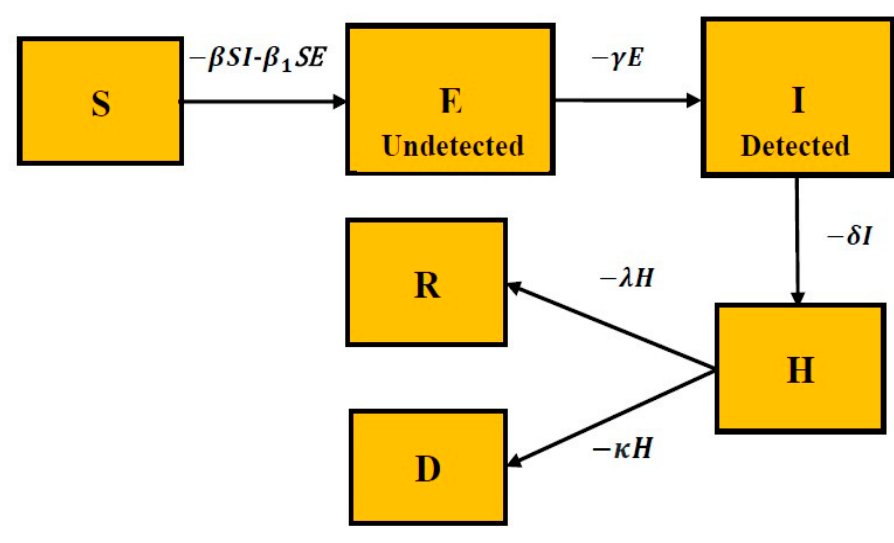
Figure 1. The proposed SEIHRD model.